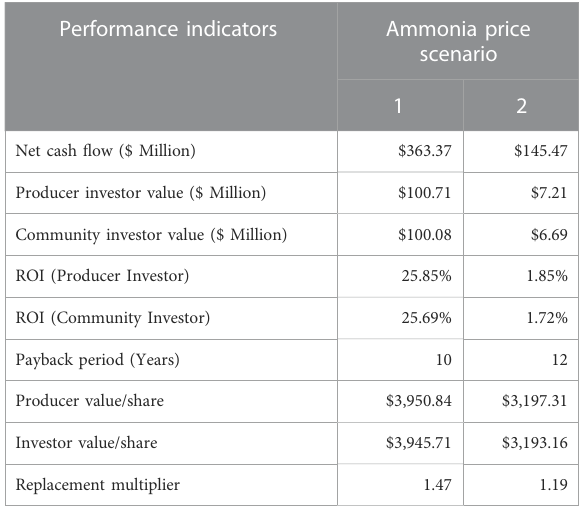
TABLE 6 Discounted performance indicators under 100% equity fi nancing situation with discount rate of 5.0% and higher ef fi ciency SOEC energy-to- ammonia technology (6.5